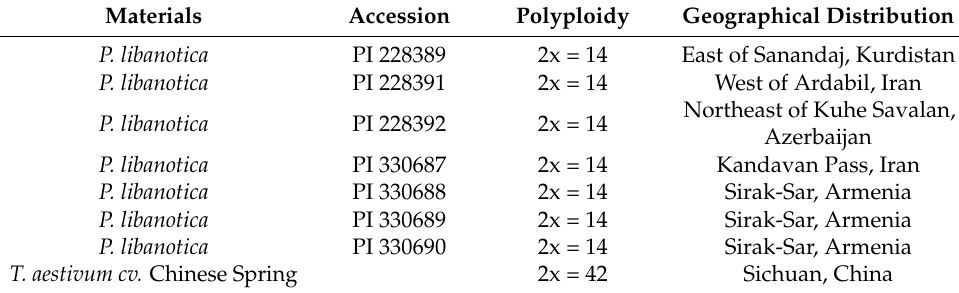
Table 4. Materials in this